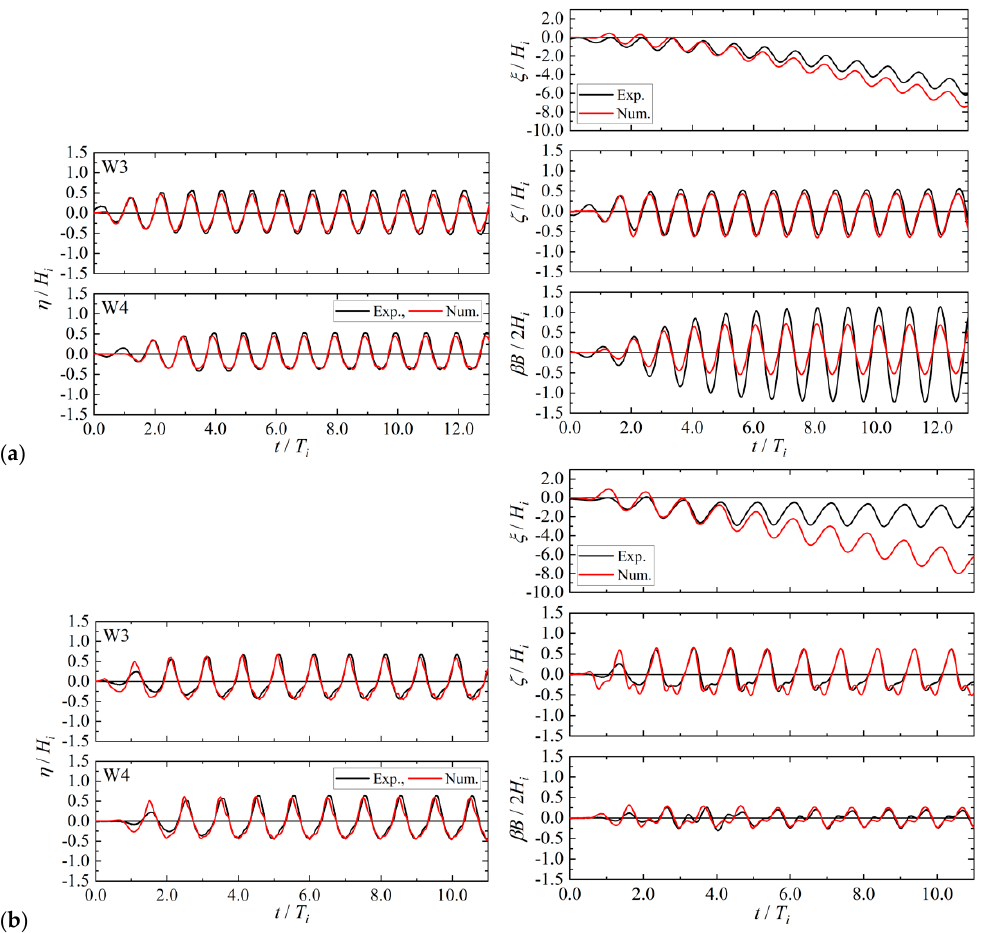
Figure 16. Comparison of the water surface fluctuations η and the surge ξ , heave ζ , and pitch β of the caisson for b f = 0 mm: ( a ) T i = 1.70 s ( f i = 0.59 Hz); ( b ) T i = 2.83 s ( f i = 0.35 Hz).